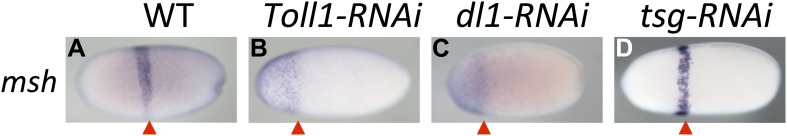
Toll signaling affects AP patterning.Expression of msh is monitored by ISH in blastoderm embryos. The view is lateral (A), or not determined as the expression is DV symmetric (B–D). The red arrowheads mark the posterior border of msh expression which is positioned at approximately 60% egg length (0% posterior pole) in wt (A) and tsg KD (D) embryos. In Toll1 and dl1 KD embryos, the msh domain expands to the anterior tip of the embryo and its posterior border is shifted anteriorly (to approximately 80% egg length).